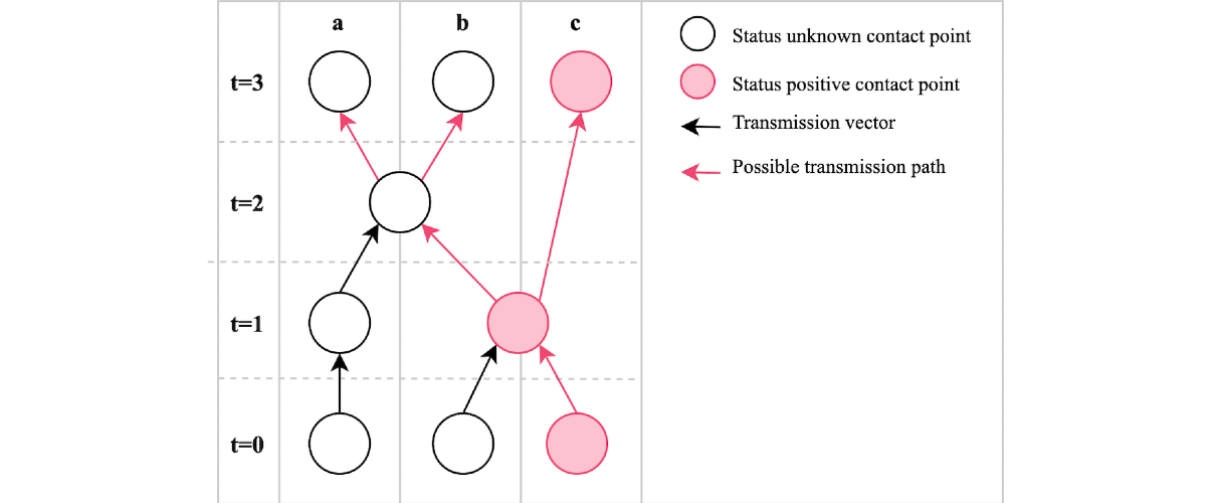
Figure 1. A network of interactions over time represented as a transmission graph. The rows represent units of time, and the columns represent individuals. By time t=3, all individuals have contact points with possible transmission paths. t: time